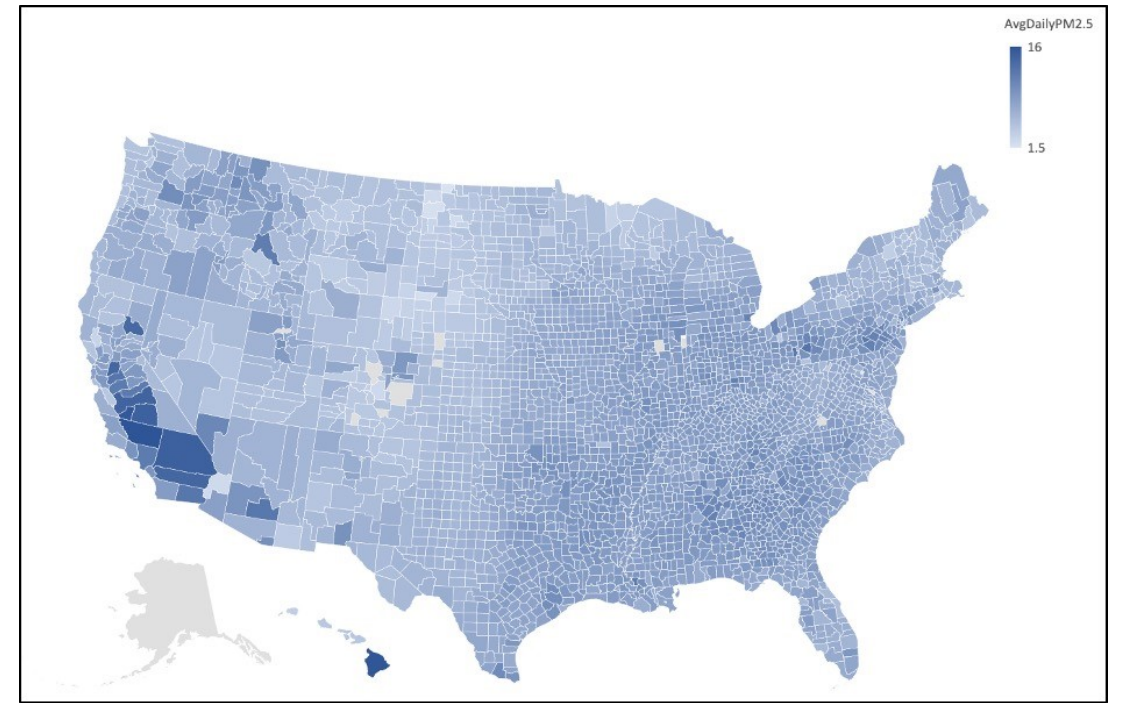
Figure 1. Average daily PM ₂ . ₅ map of U.S. counties. Map of the average daily PM ₂ . ₅ for each country in the United States, excluding Alaska. Clusters of higher PM ₂ . ₅ concentration can be seen in the Detroit, MI and Philadelphia, PA regions, California’s Central Valley, and in Hawaii.